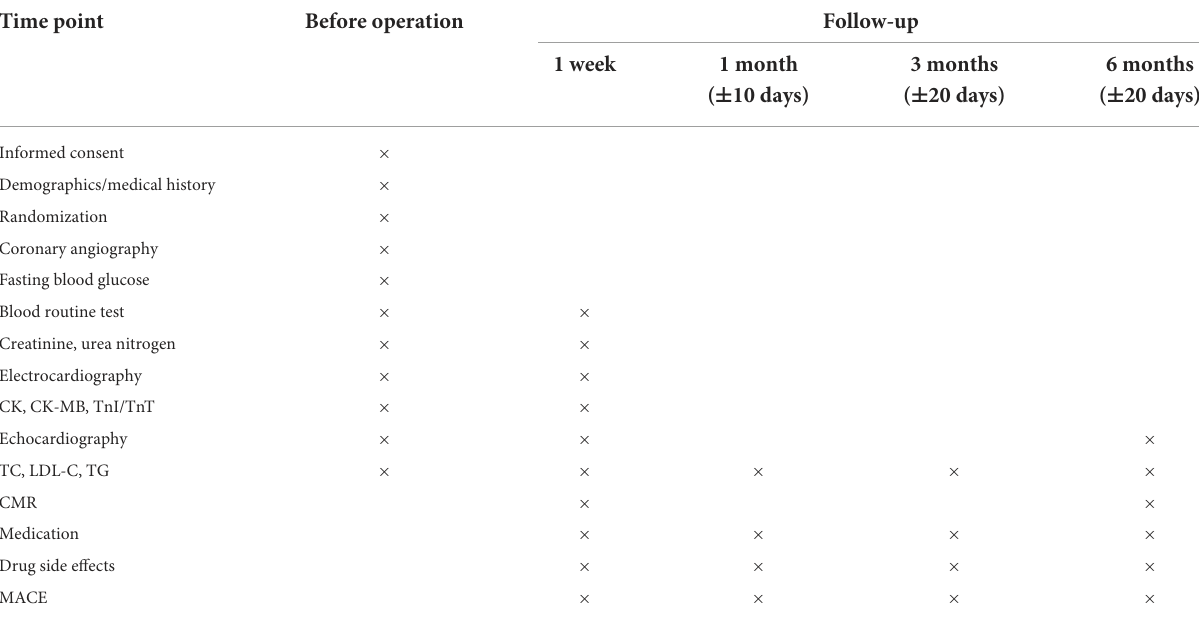
TABLE 2 Timetable of activities planned during the